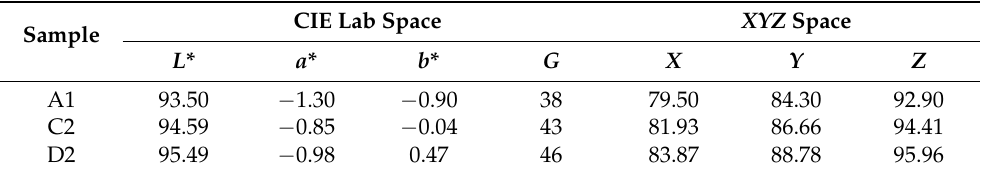
Table 1. Initial colorimetric values of tested paints measured at both color spaces (CIE Lab and XYZ ).